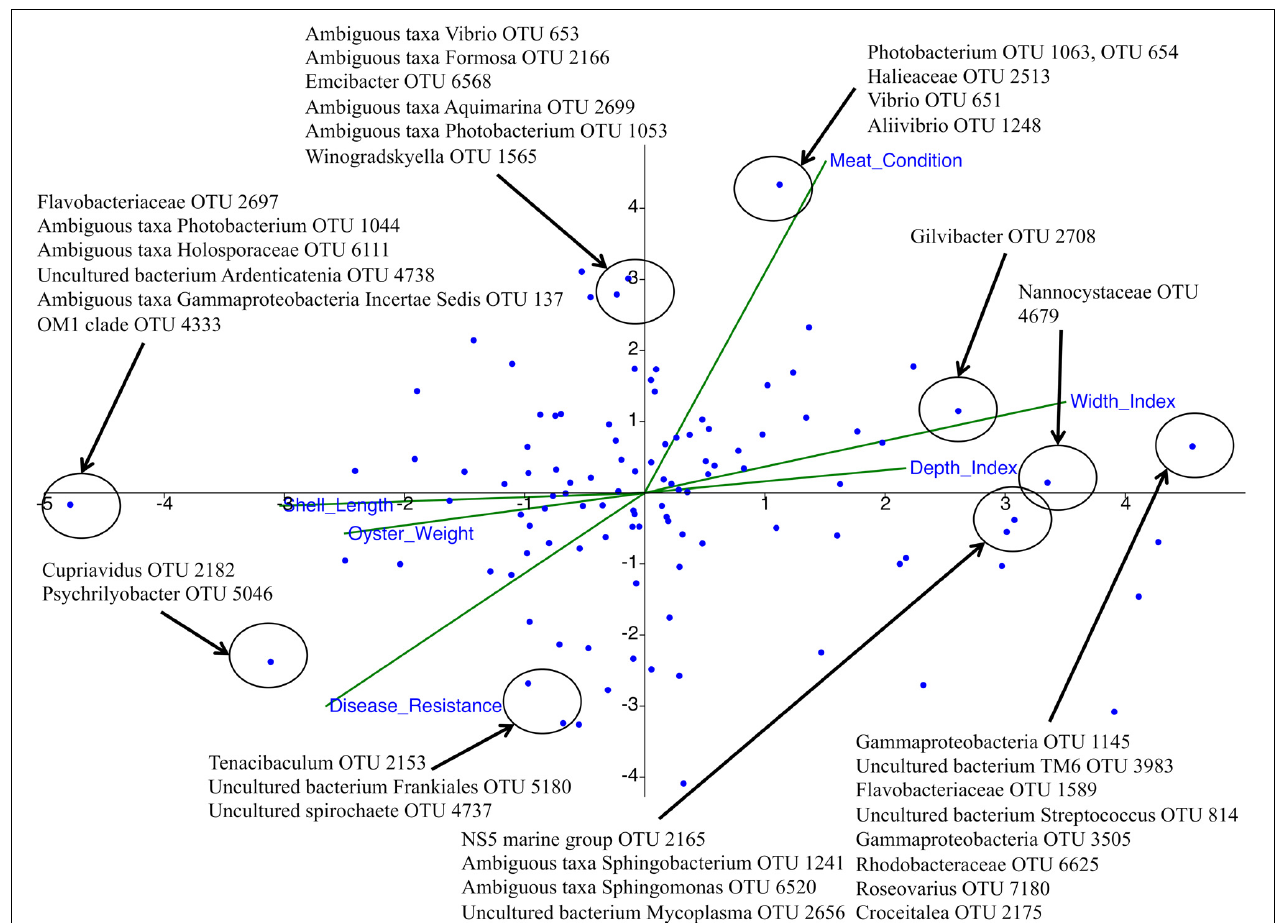
FIGURE 3 | Canonical correspondence analysis (CCA) plot using 3% relative abundance filtered data. Cupriavidus , Psychrilyobacter , Tenacibaculum, and Frankiales were found to be strongly associated with OsHV-1 µ var disease-resistance, while OTUs assigned to the Photobacterium , Vibrio, and Aliivibrio were negatively associated with OsHV-1 µ var disease-resistance. Axis 1 and 2 were able to significantly represent 53.2% of the data ( p = 0.001 for both axes with 999